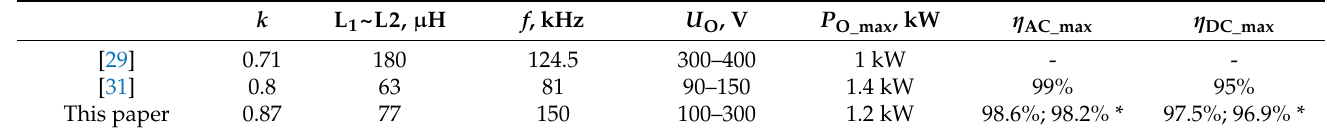
Table 3. Comparison of IPT systems.